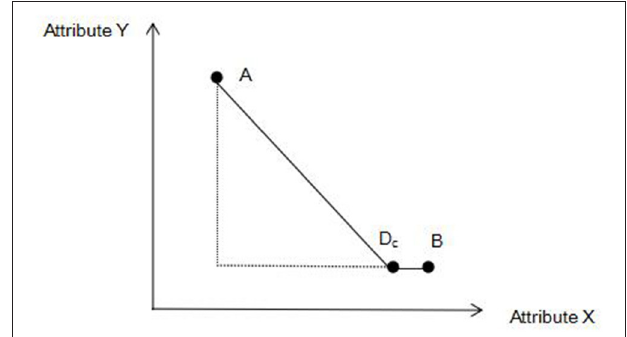
FIGURE 1 | Schematic diagram of the mechanism of decoy